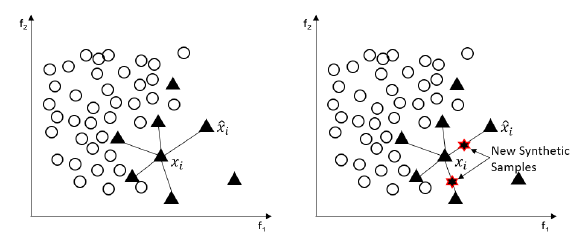
Figure 3. SMOTE working procedure [53]